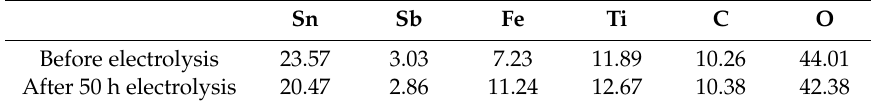
Table 3. The surface element content of magnetic particles before and after